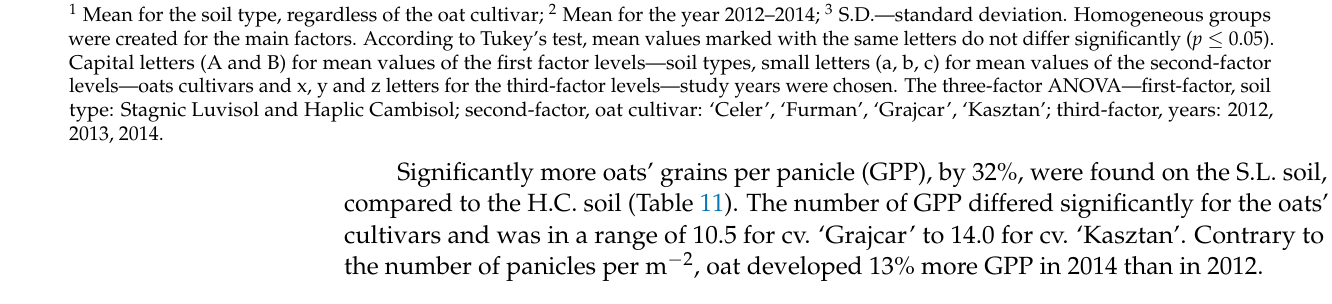
Table 11. Number of grains (pieces) per oat panicle in the mixtures depending on the soil type (factor I), oat cultivar (factor II), and study years (factor